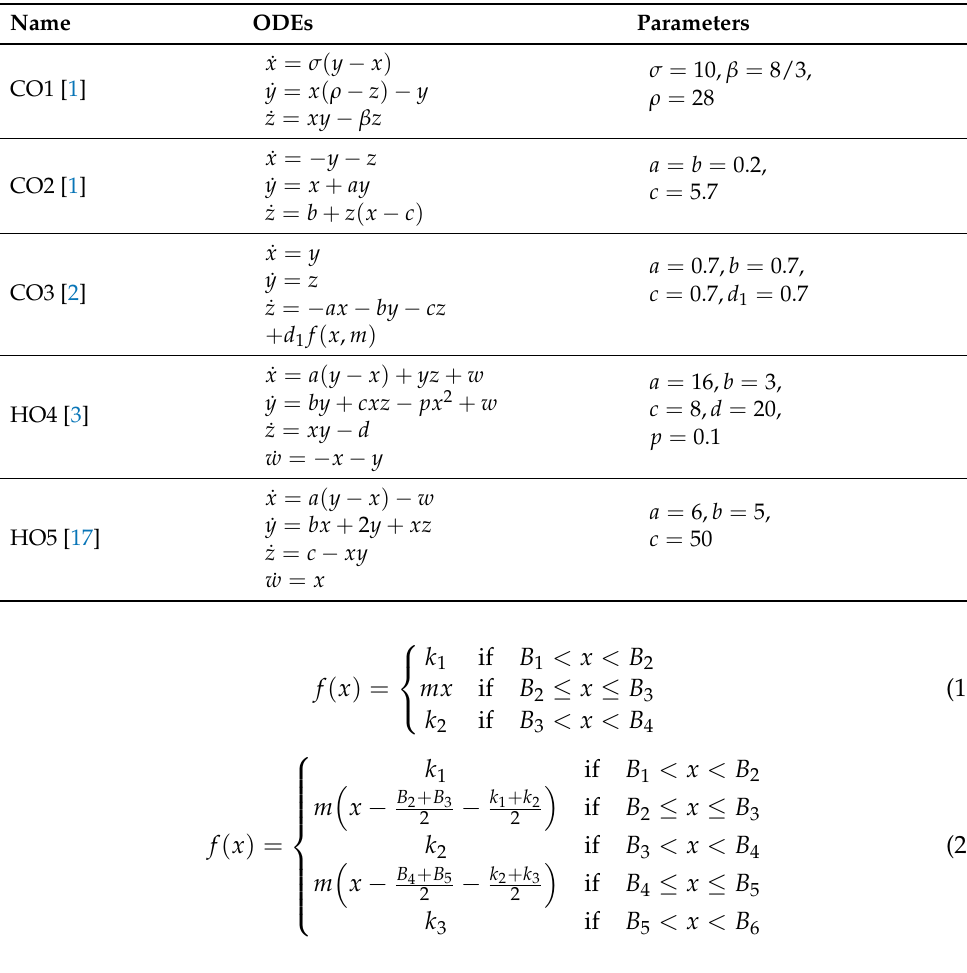
Table 1. Chaotic and hyper-chaotic